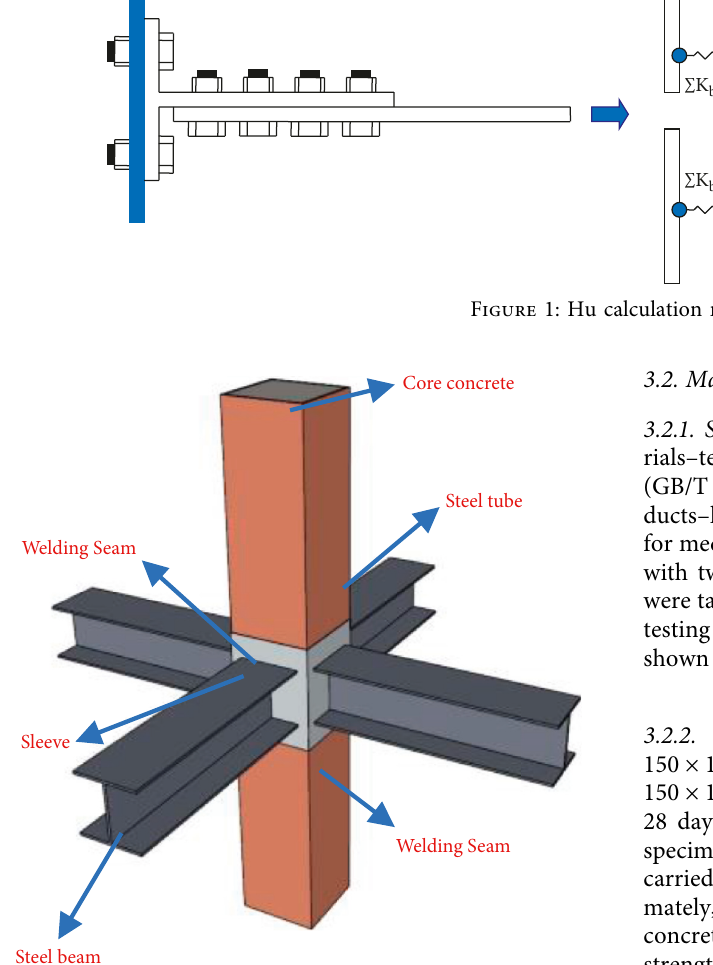
Figure 2: Sketch of sleeve Table 1: Sleeve parameters of specimens height × side length- × thickness (mm). CFST-1 CFST-2 CFST-3